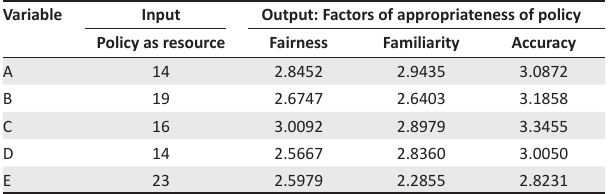
TABLE 5: Quantification of credit management policies and students’